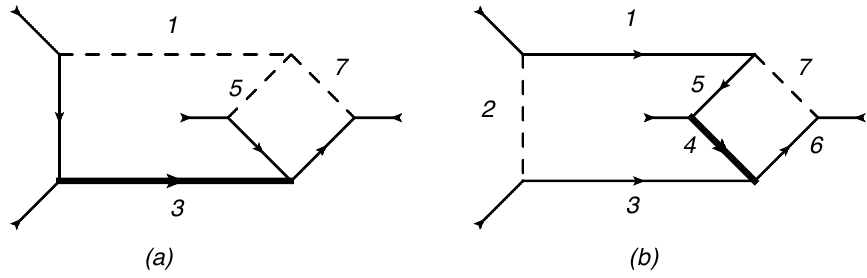
Figure 10 . (a) Representation of the surface S 1 S 7 , at which the dashed lines k 1 , k 7 and k 5 have zero momentum, and at which the heavy line, A 3 = s . Other internal lines carry a momentum equal to that of an external line. (b) Representation of a typical double-soft region at which two lines are